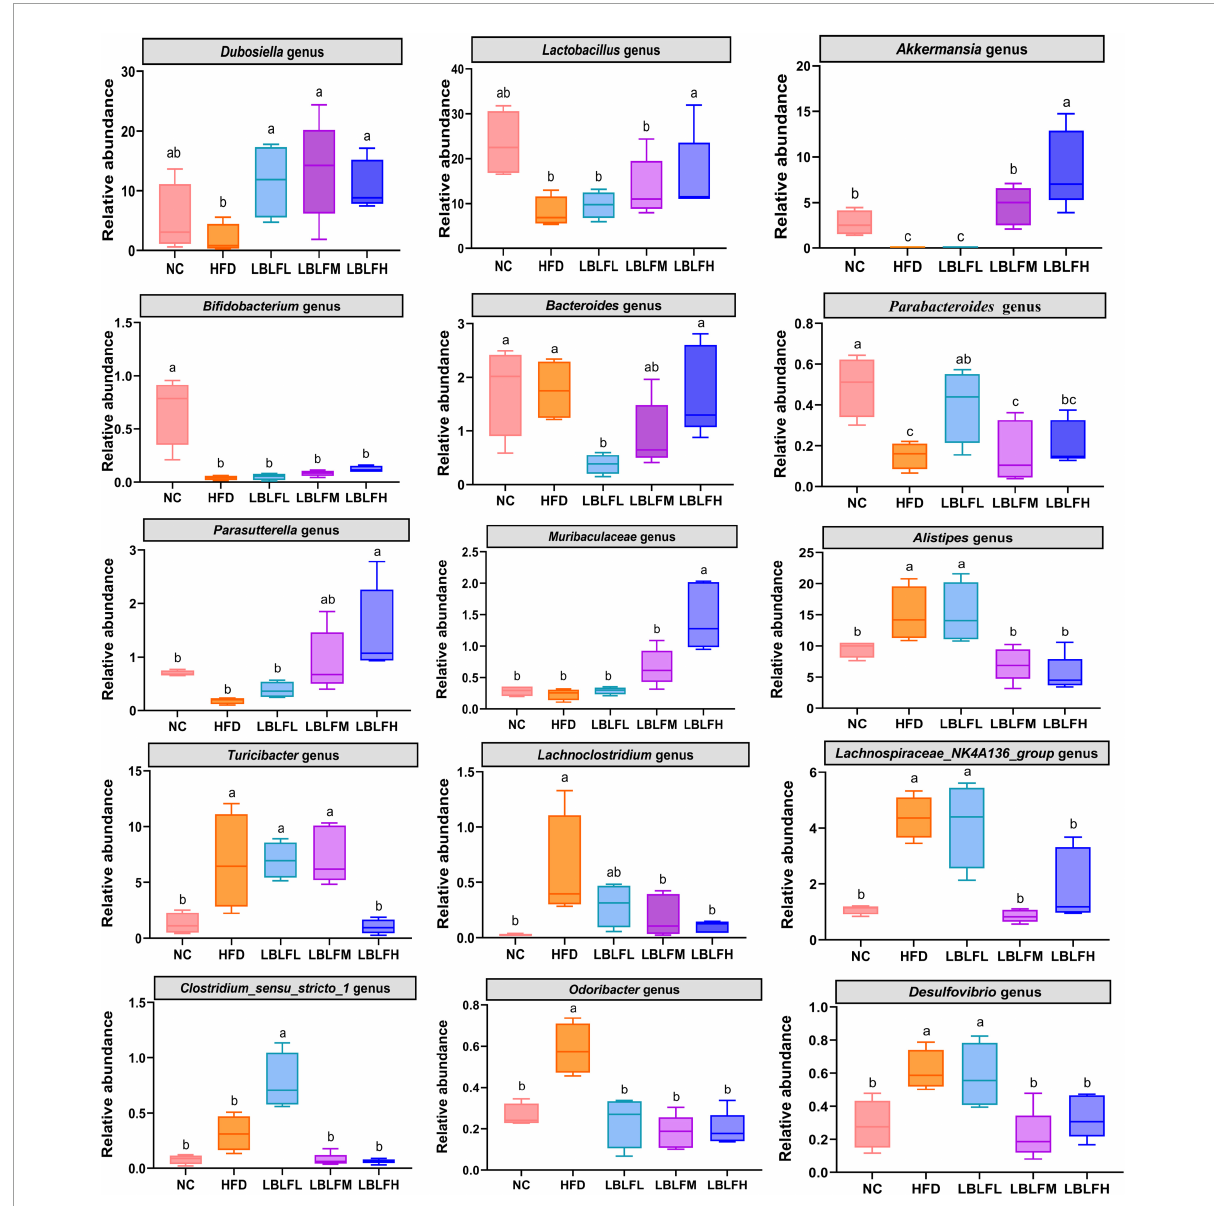
FIGURE7 Comparison of relative abundances of the 15 vital intestinal microbes at the genus level. Different lowercase letters with significant differences ( p <